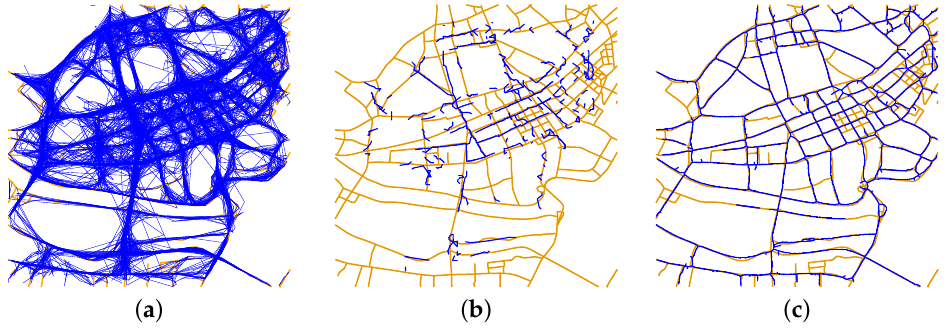
Figure 6. Inferred road networks overlapped with the ground truth map of the Wuhan dataset. ( a ) Road network generated by Edelkamp and Schrödl’s method; ( b ) road network generated by Biagioni and Eriksson’s method; ( c ) road network generated by Davies’